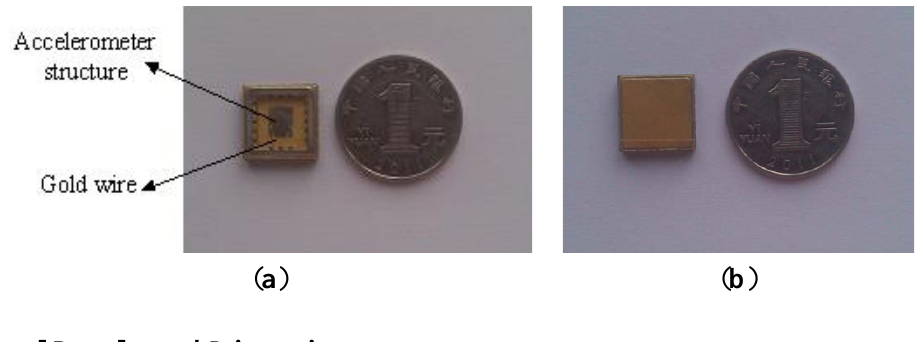
Figure 16. ( a ) The structure after wire bonding; ( b ) The structure after cap